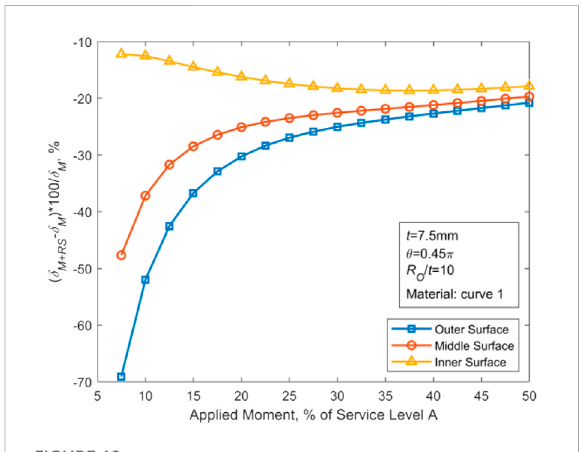
FIGURE 12 Negative COD attheCTWC innerwallposition ofthin-walled pipe.